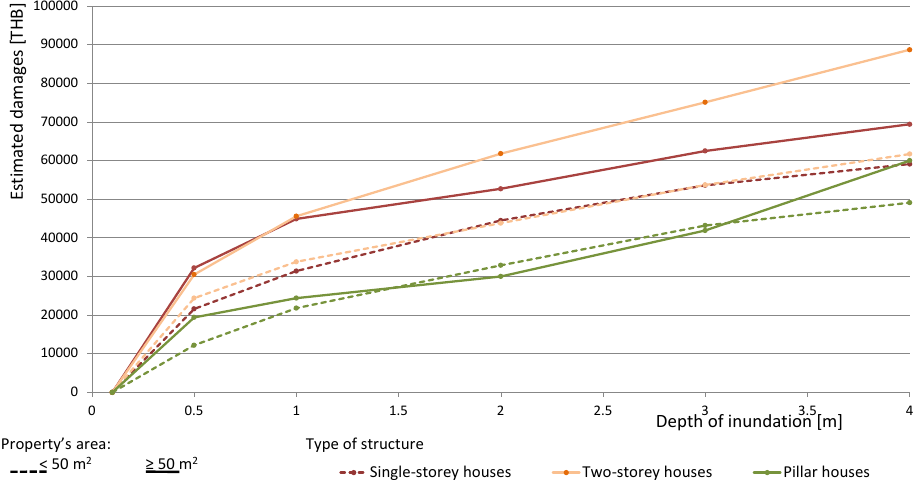
Figure 7. Example of the model simulation results, expressing computed flood depths for different combinations of flood protection measures (( a ) current situation—Scenario 1, or “business as usual”; ( b ) combination of measures—Scenario 4; and ( c ) combination of measures—Scenario 7), 2011 flood event. The combination of measures included a variety of measures such as regional, local and combinations between regional and local (Table 1).